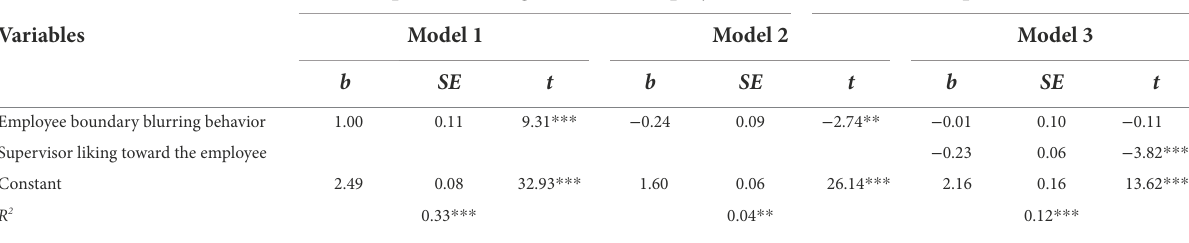
TABLE 2 The effects of employee boundary blurring behavior and supervisor liking toward the employee on abusive supervision in Study 1.